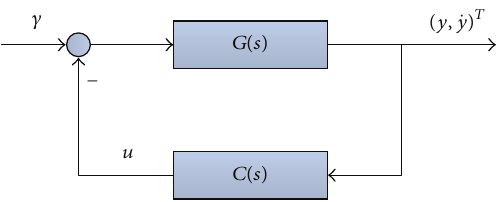
Figure 7: Indirect closed-loop identification